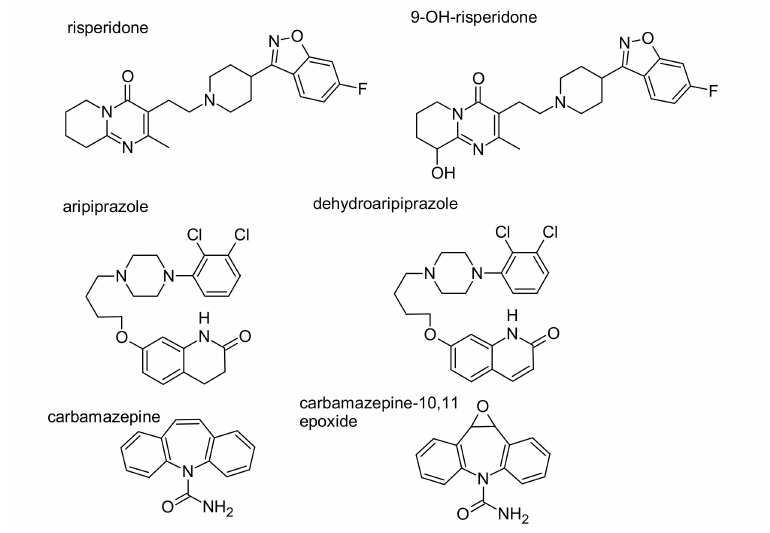
Figure 1. Chemical formulas of the analyzed substances and their metabolites.